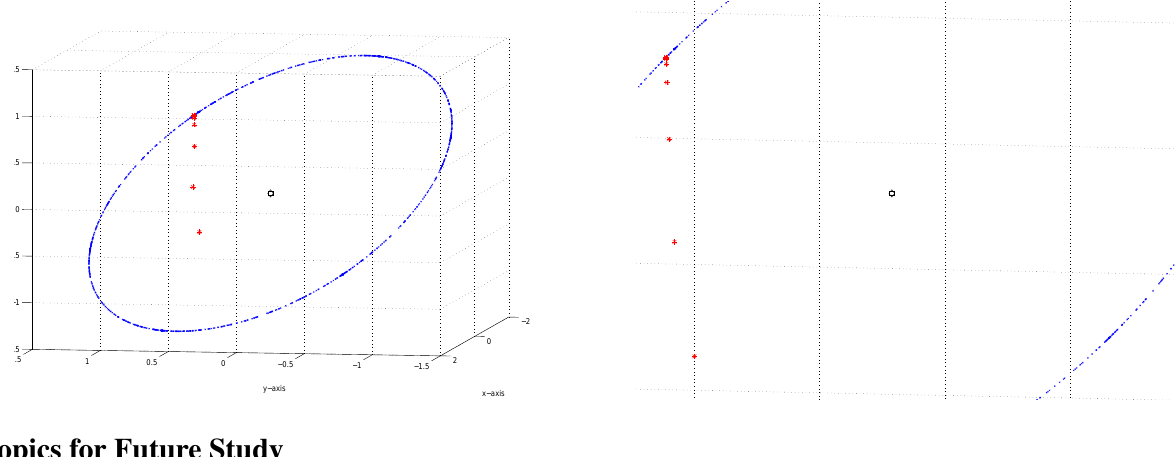
Figure 14. (Left) Example of convergence to set of fixed points, (Right) Close-up of Example.